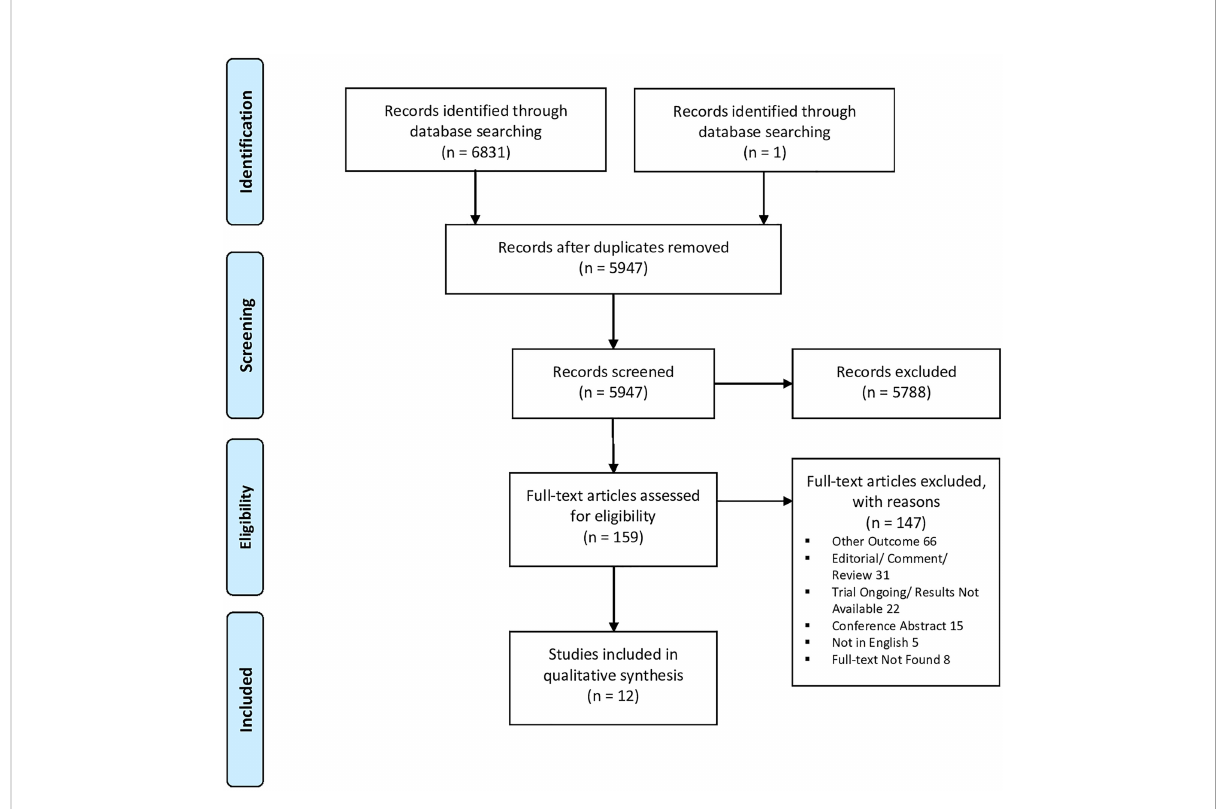
FIGURE 1 Prisma fl ow diagram of the